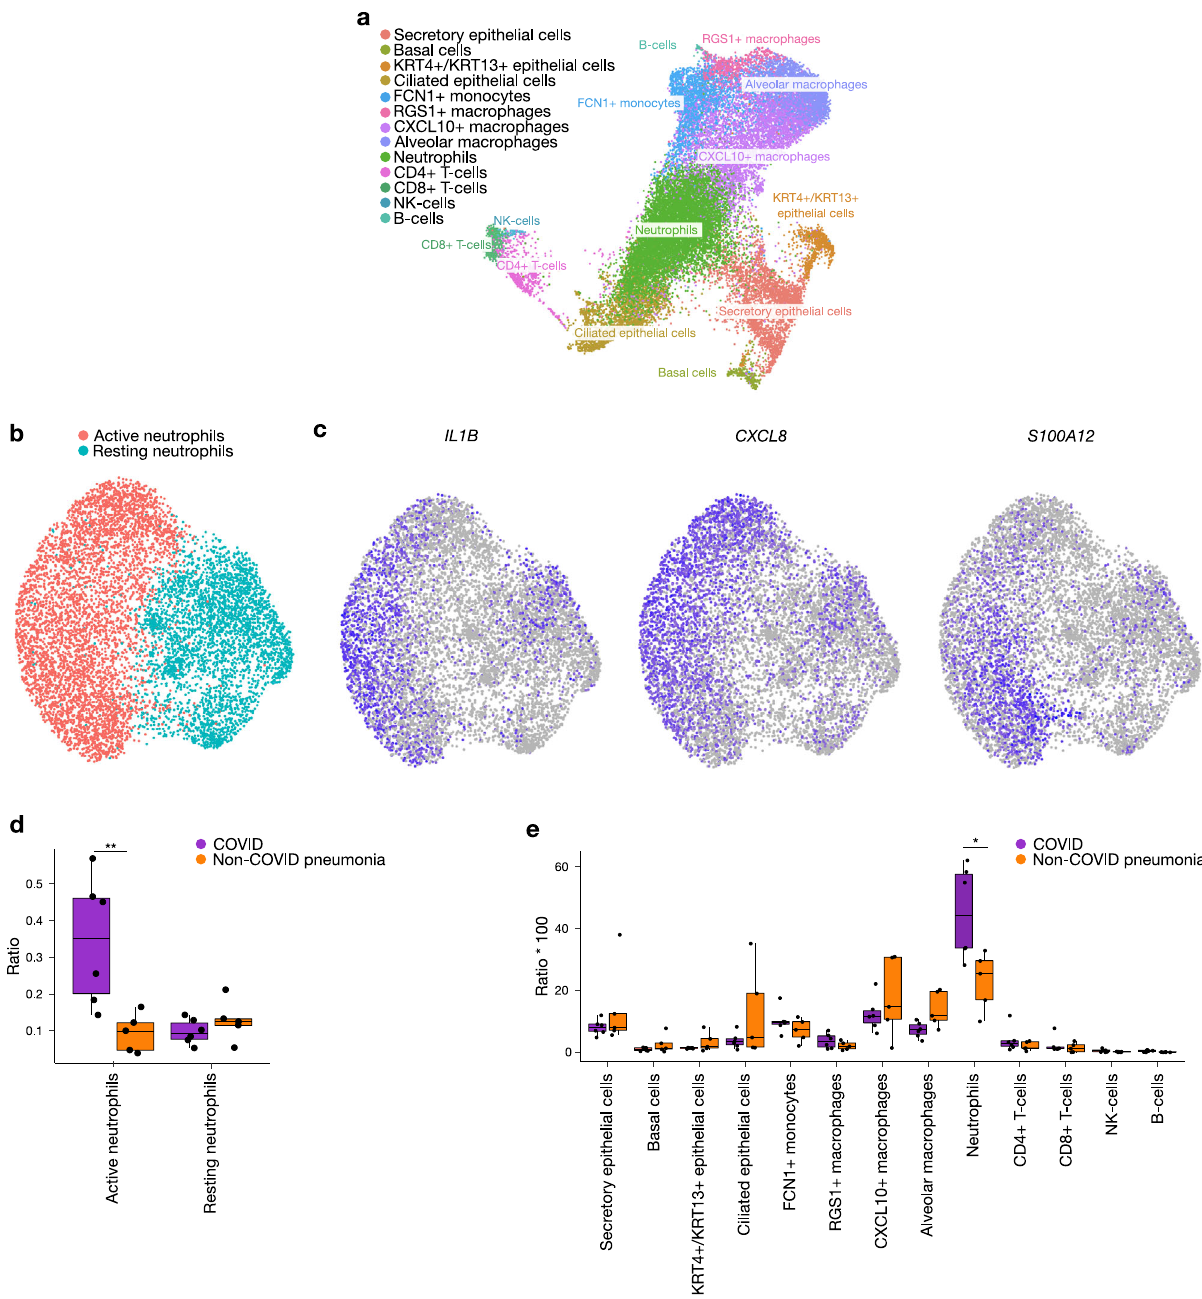
Fig. 5 Contribution of neutrophils to COVID-19 immunopathology at a local level: scRNA-seq data of COVID-19 BAL fl uid. UMAP plot of 26,605 single cells (from 11 patients, n = 6 for COVID-19, n = 5 for non-COVID pneumonia), colour-coded per cell type ( a ) and UMAP showing active and resting neutrophil subclusters ( b ) present in the bronchoalveolar lavage fl uid of COVID-19 and non-COVID pneumonia patients. c Feature plots of key differentially expressed genes, with IL1B, CXCL8 and S100A12 being upregulated in the active neutrophil population. d Boxplots showing a signi fi cant abundance of active neutrophils in COVID-19 pneumonitis, as compared to non-COVID pneumonia. Boxplot representation (centre line, mean; box limits, upper and lower quartiles; whiskers, range; points, data points per patient). A two-sided Wilcoxon rank-sum test was used, p = 0.009 active neutrophils COVID vs Non- COVID pneumonia. e Relative immune cell type abundance in bronchoalveolar lavage fl uid of COVID-19, compared to non-COVID pneumonia. Boxplot representation (centre line, mean; box limits, upper and lower quartiles; whiskers, range; points, data points per patient). A two-sided Wilcoxon rank-sum test was used, p = 0.017 neutrophils COVID vs non-Covid pneumonia. Source data are provided as a Source data fi le. Signi fi cance is shown as * p < 0.05; ** p < 0.01. See also Fig.